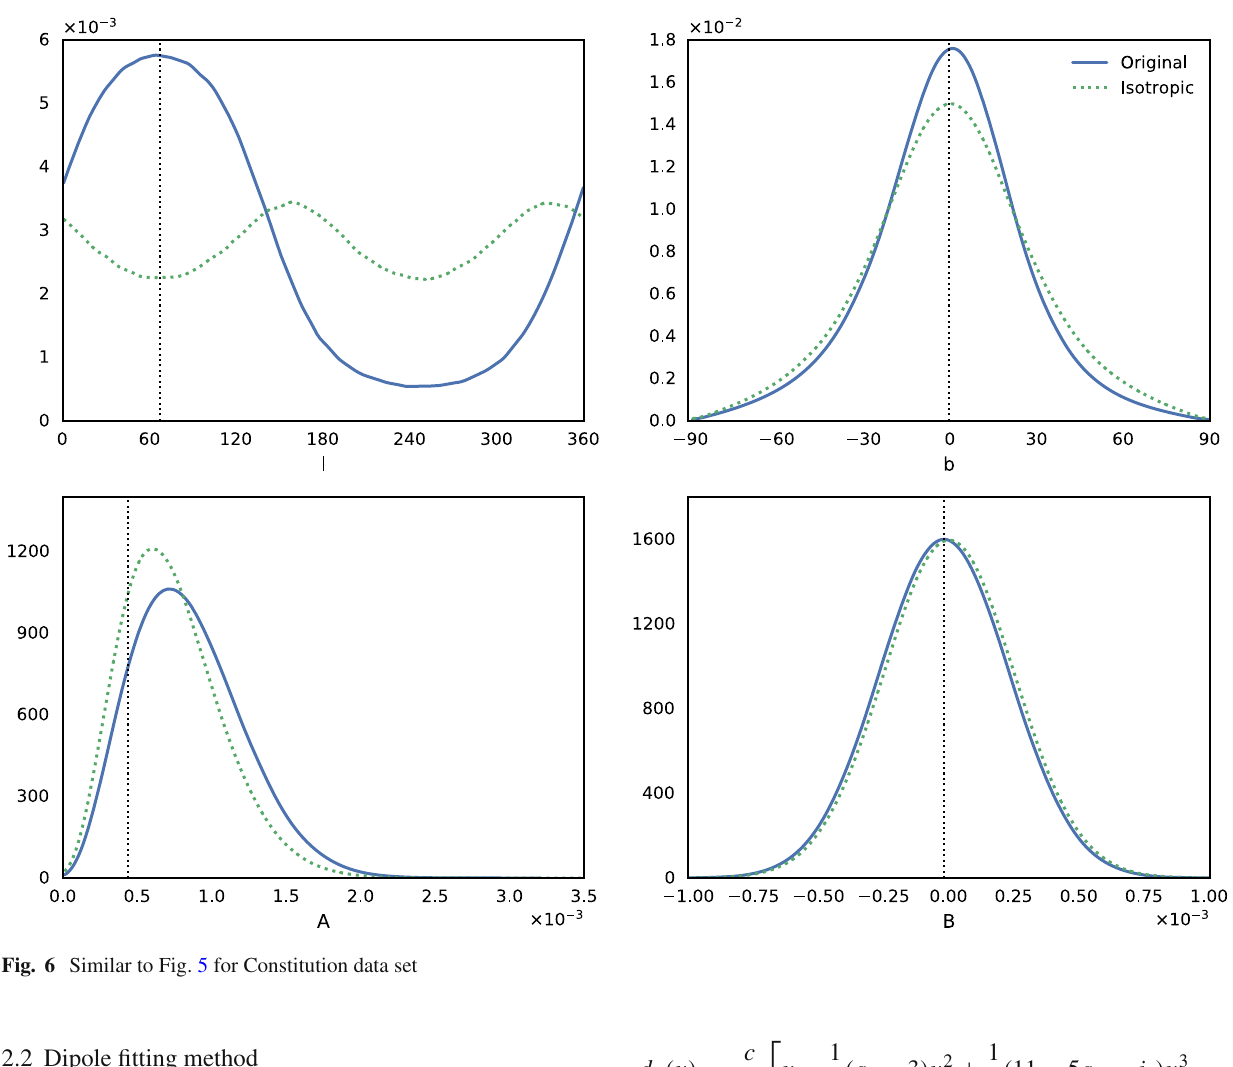
Fig. 6 Similar to Fig. 5 for Constitution data